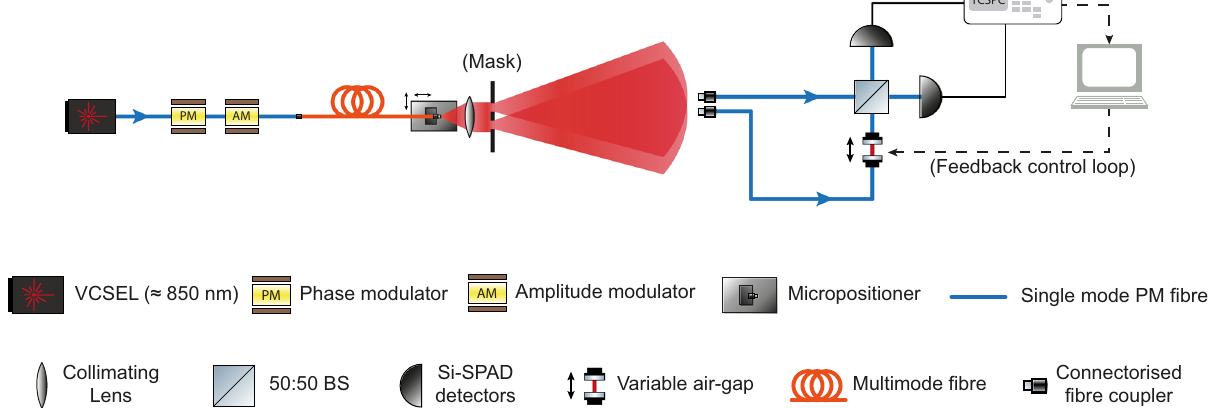
Fig.3|Experimentalset-up. AVCSELoperatedinpulsedmodegeneratescoherent states that are phase and amplitude modulated to reproduce a pseudo thermal state.Thesestatesarethencoupledintoamultimode fi breandthencollimatedtoa customopticalmaskshapingthelightbeamintotwopseudo-point-likesources.At 1m distance, two single-mode polarisation-maintaining fi bres collect